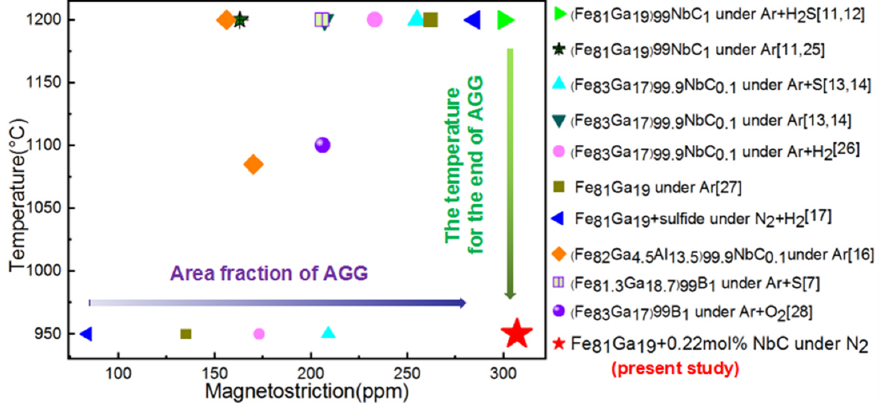
Figure 9. Final annealing temperatures and magnetostriction coefficients in Fe–Ga alloys corre- sponding to chemical compositions and annealing atmosphere.